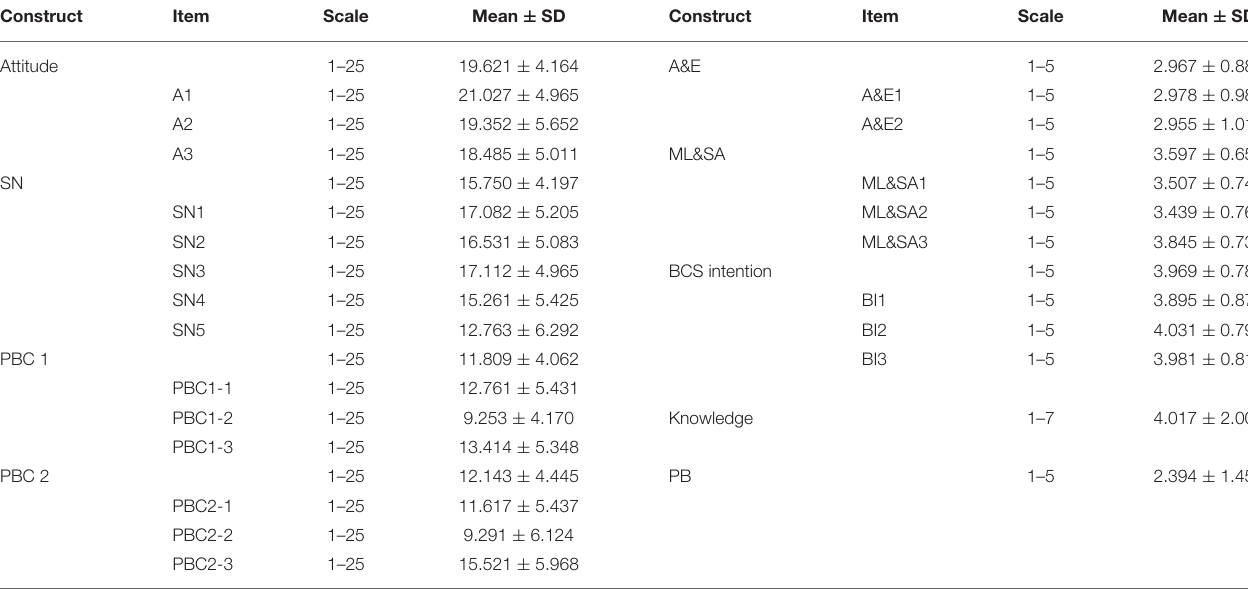
TABLE 2 | Mean scores for every item ( n =